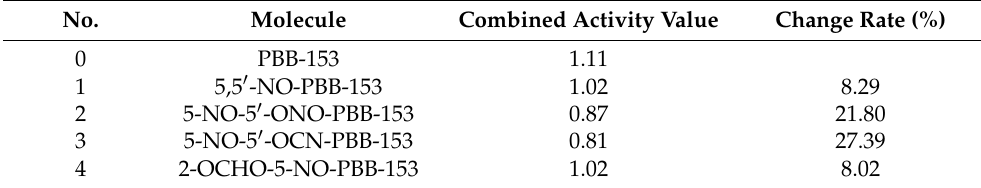
Table 2. The combined activity of bioconcentration, long-range transport, and the highest infrared signal before and after the modification of hexabromobiphenyl (PBB-153). No. Molecule Combined Activity Value Change Rate